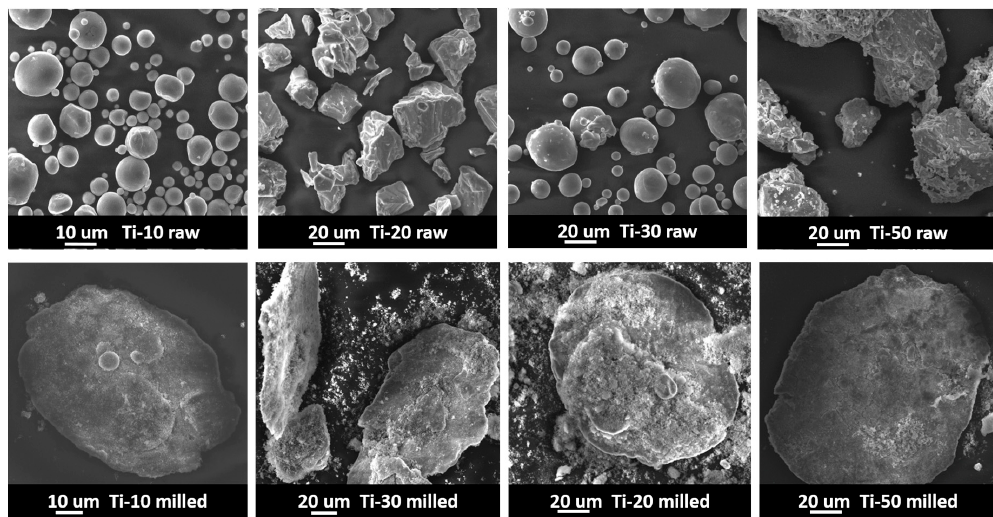
Figure 4. The scanning electron microscopy (SEM) powder morphology images of the raw and ball-milled Ti-10, Ti-20, Ti-30 and Ti-50 powders, respectively.